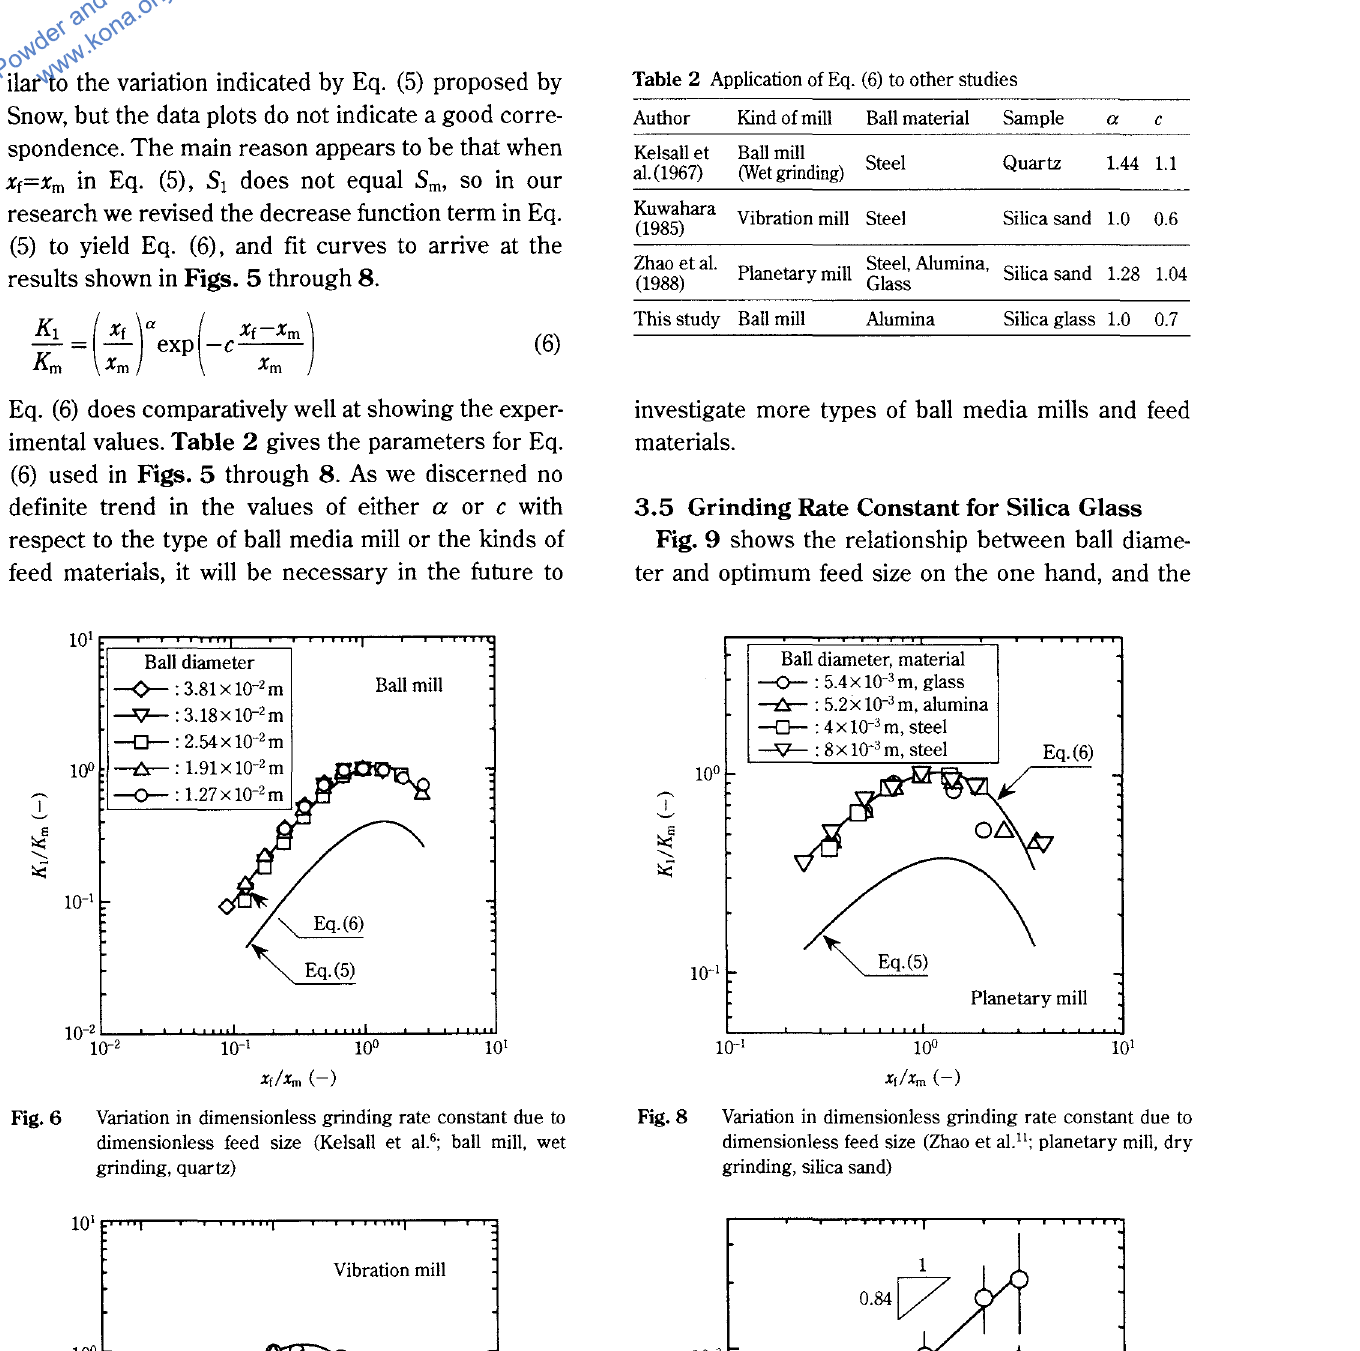
Fig. 6 Variation in dimensionless grinding rate constant due to dimensionless feed size (Kelsall et a1. 6; ball mill, wet grinding, quartz)